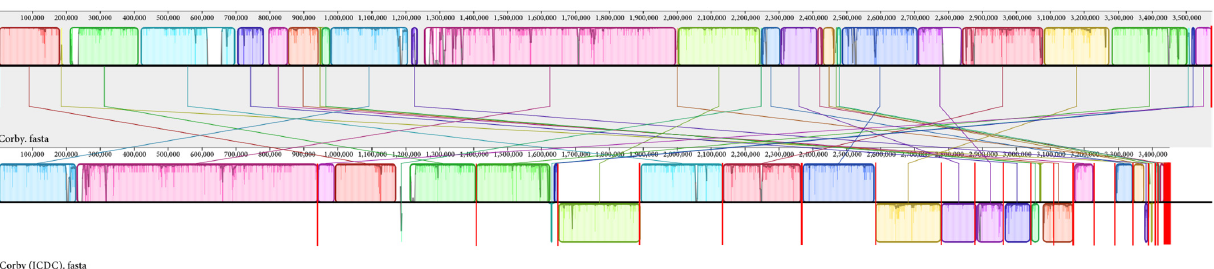
Figure 4. The phylogenetic tree is based on the core genes of Legionella pneumophila . The whole ge- nome of L. pneumophila strain Corby (ICDC) (red label) isolated from a patient was compared to the genomes of serotype 1 L. pneumophila .